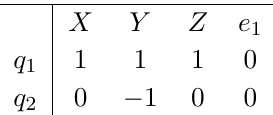
with respect to the basis of e(cid:11)ective 4